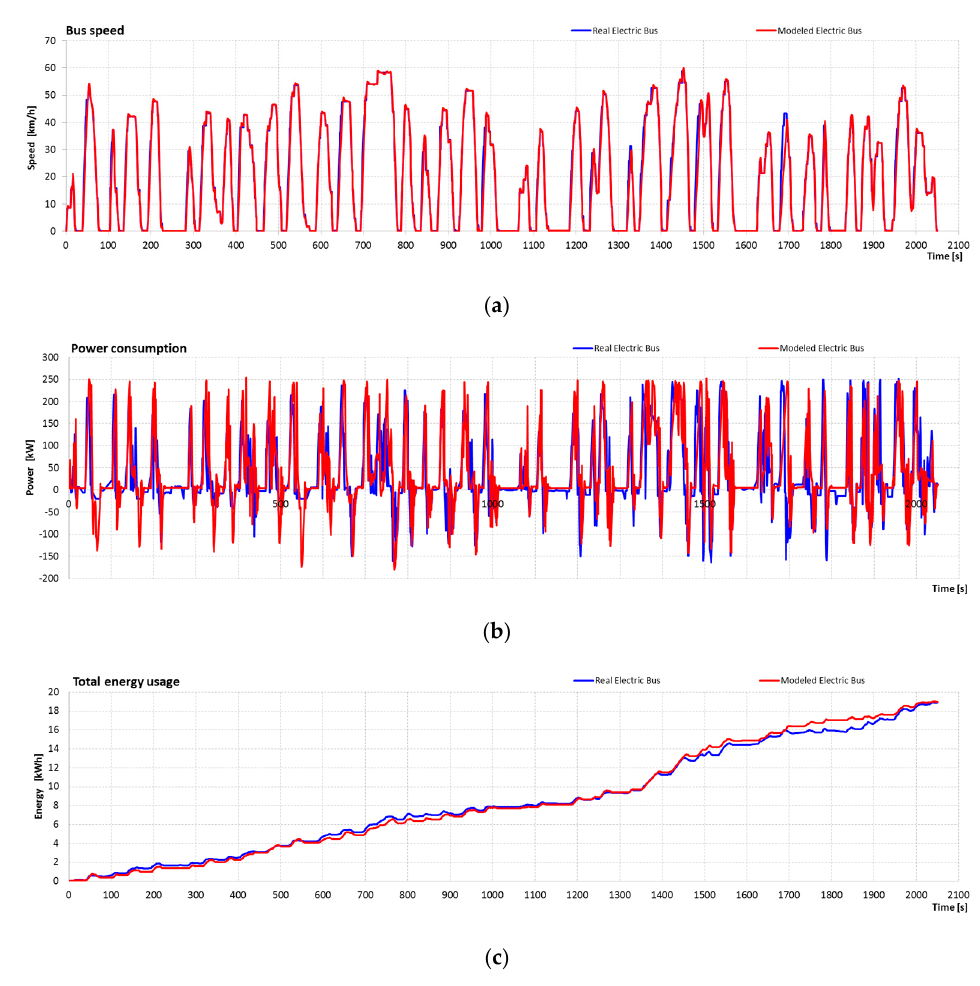
Figure 4. Comparison of parameters registered during the operation of the actual vehicle and a modeled vehicle with the Lithium Iron Phosphate (LFP) energy store: ( a ) vehicle speeds, ( b ) power of energy store, and ( c ) total energy consumption.